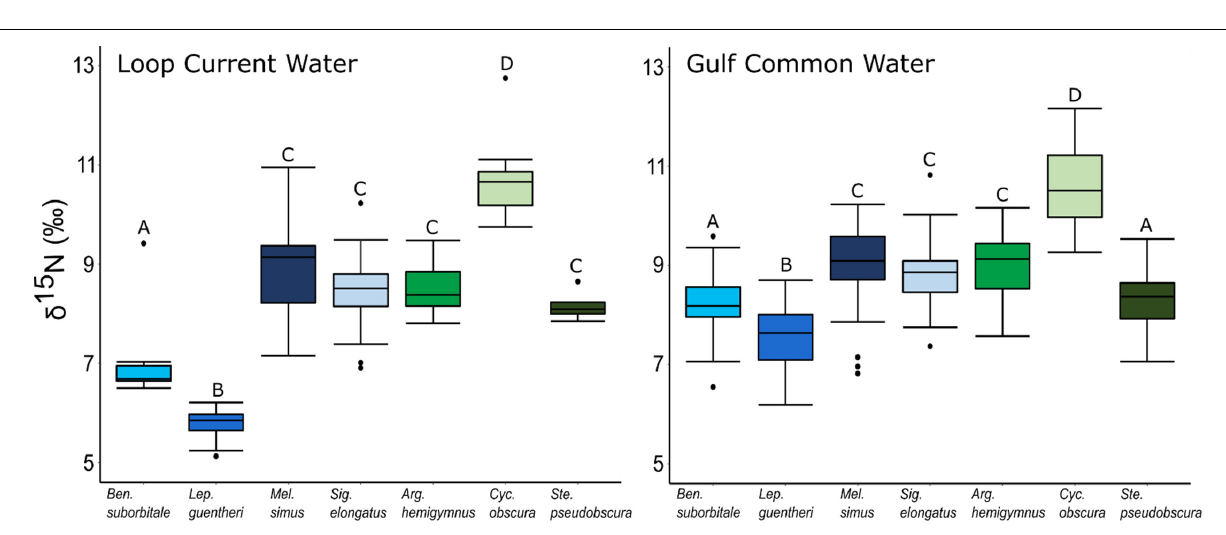
FIGURE 5 | Boxplots depicting interspecific differences in mean ( ± SD) δ 15 N values for migratory (blue shades) and non-migratory (green shades) deep-pelagic fishes collected in Loop Current water and Gulf common water. Differing letters among species denote significant